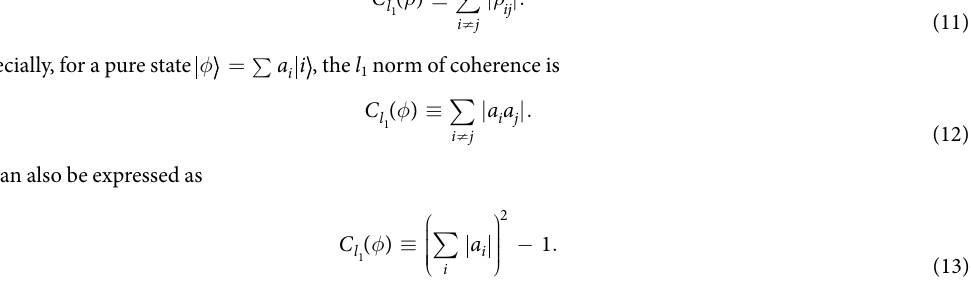
Figure 2. The comparison between Φ + Ψ + C C ( ( ) 1)( ( ) 1) Ψ C ( ) are set as[0, l 1